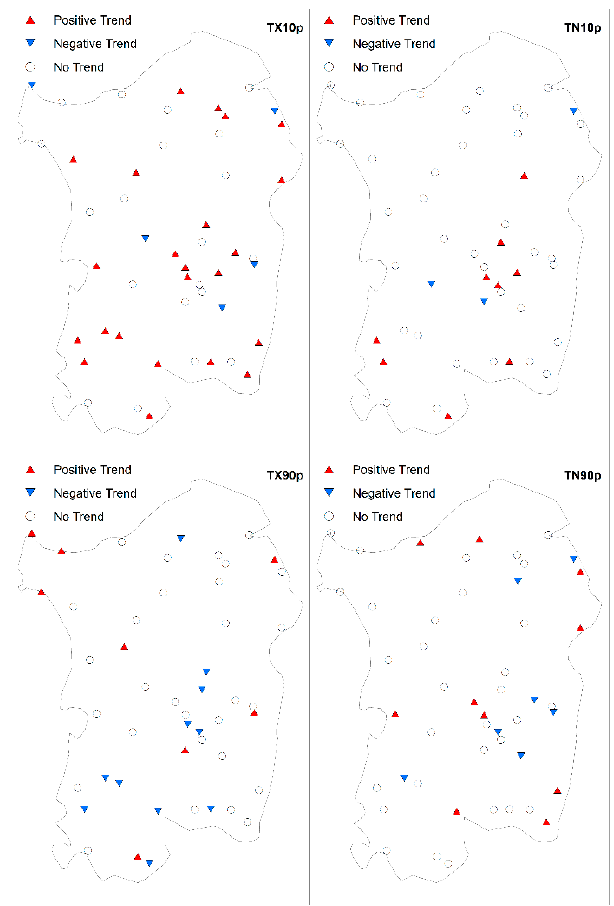
Figure 8. Spatial distribution of extreme temperature indices trend (TX10p, TN10p, TX90p and TN90p; see Table 3 for abbreviation definitions).